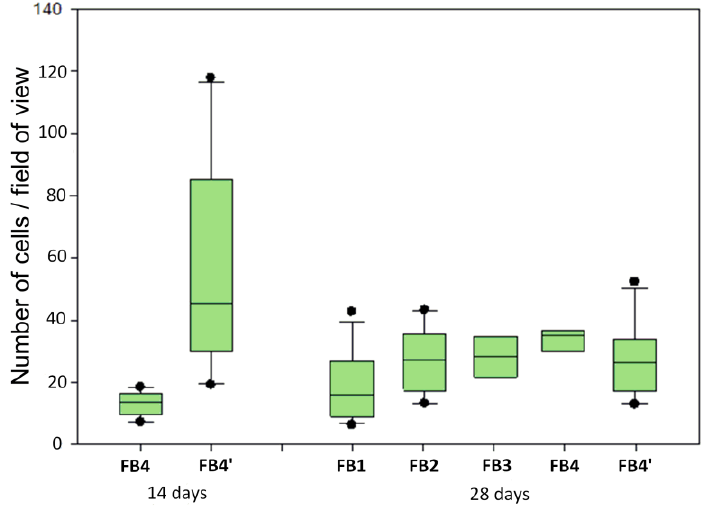
Figure 11. Number of CD68+ at the border of the polymer film and fibrous capsule.